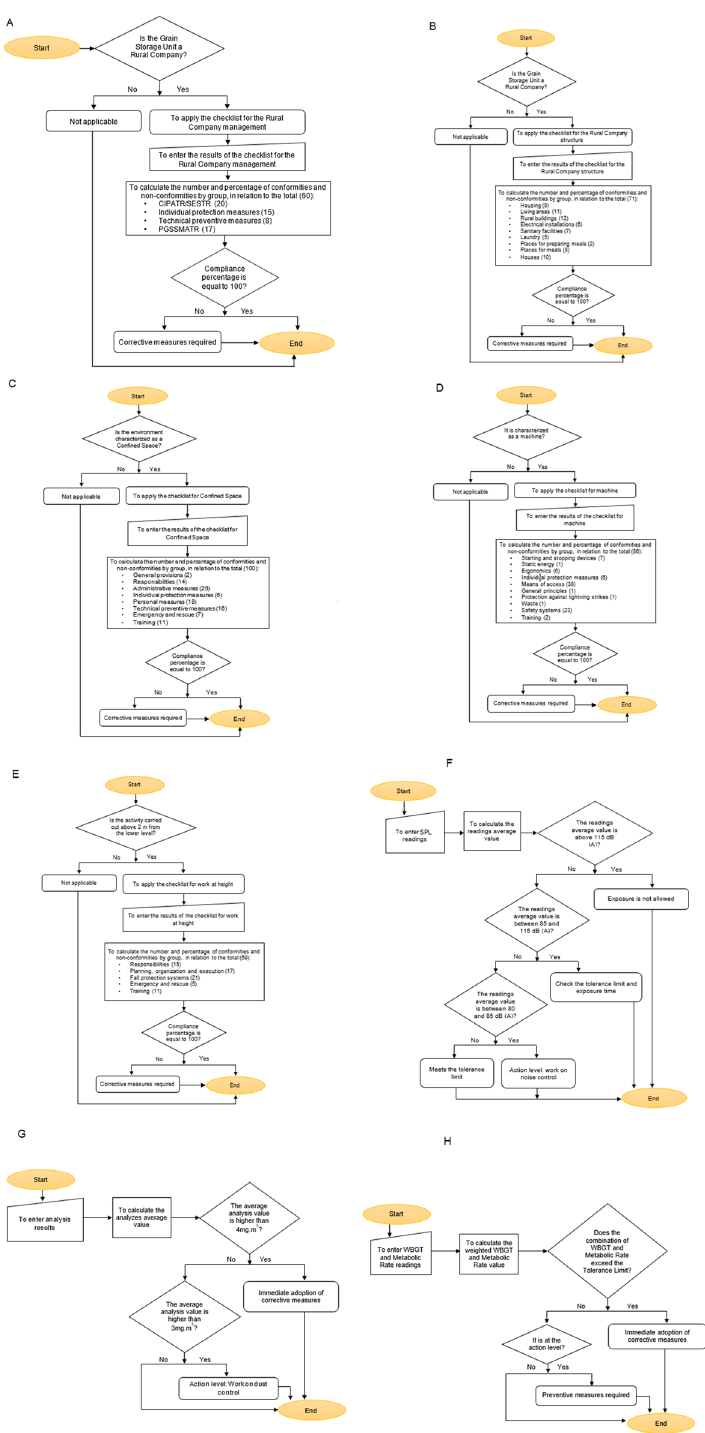
Figure 3. Chart flow to algorithm development on rural company safety management ( A ), chart flow to algorithm development on rural company safety structure ( B ), chart flow to algorithm development on safety at confined space ( C ), chart flow to algorithm development on safety at machinery and equipment ( D ), chart flow to algorithm development on safety at work at height ( E ), chart flow to algorithm development on noise measurement ( F ), chart flow to algorithm development on dust measurement ( G ), chart flow to algorithm development on heat stress measurement ( H